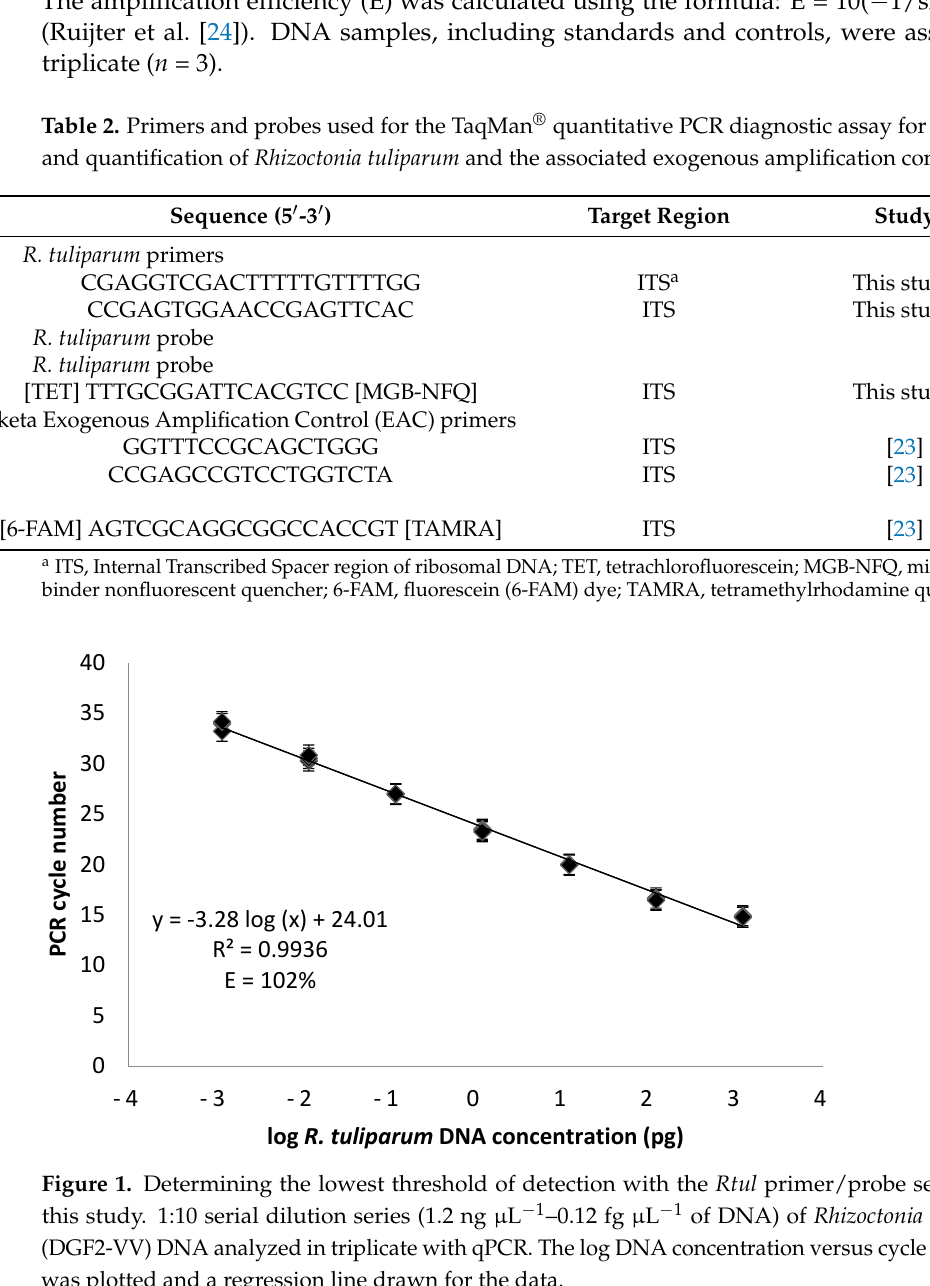
Figure 1. Determining the lowest threshold of detection with the Rtul primer/probe 149 set used in this study. 1:10 serial dilution series (1.2 ng μL -1 - 0.12 fg μL -1 of DNA) 150 of Rhizoctonia tuliparum (DGF2-VV) DNA analyzed in triplicate with qPCR. The 151 log DNA concentration versus cycle threshold was plotted and a regression line 152 drawn for the data. 153